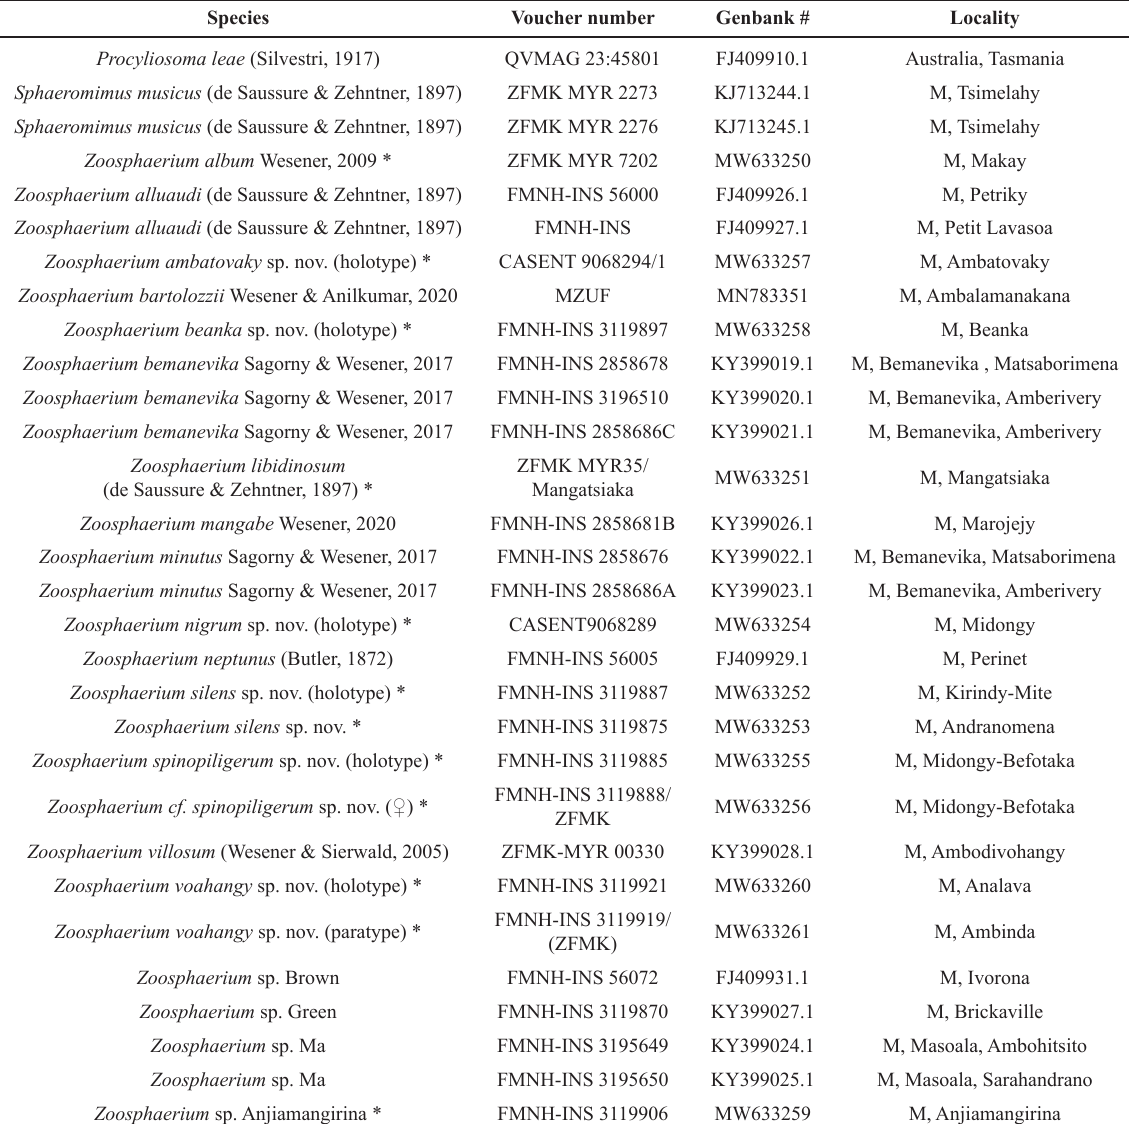
Table 1. Material examined for molecular data. CAS = California Academy of Sciences, San Francisco; FMNH = Field Museum of Natural History, Chicago; MZUF = Museum “La Specola”, Florence, Italy; ZFMK = Zoological Research Museum Alexander Koenig, Bonn, Germany. Specimens marked by an asterisk (12) were newly sequenced for this study. M =